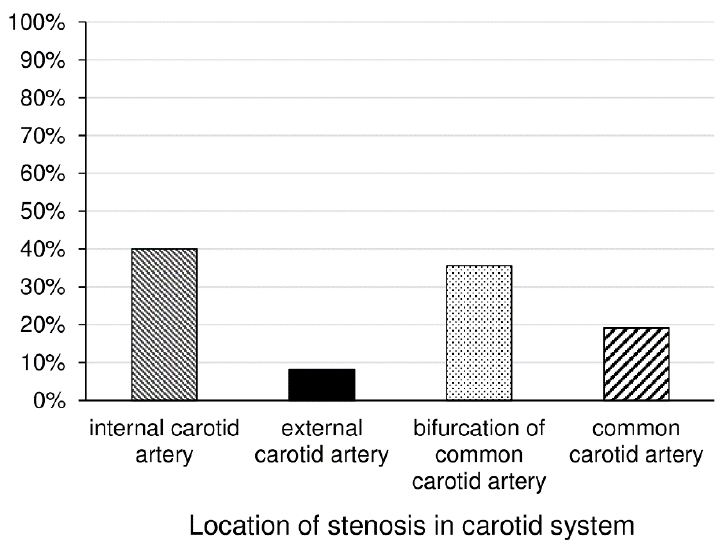
Figure 2. Location of stenosis in carotid system.